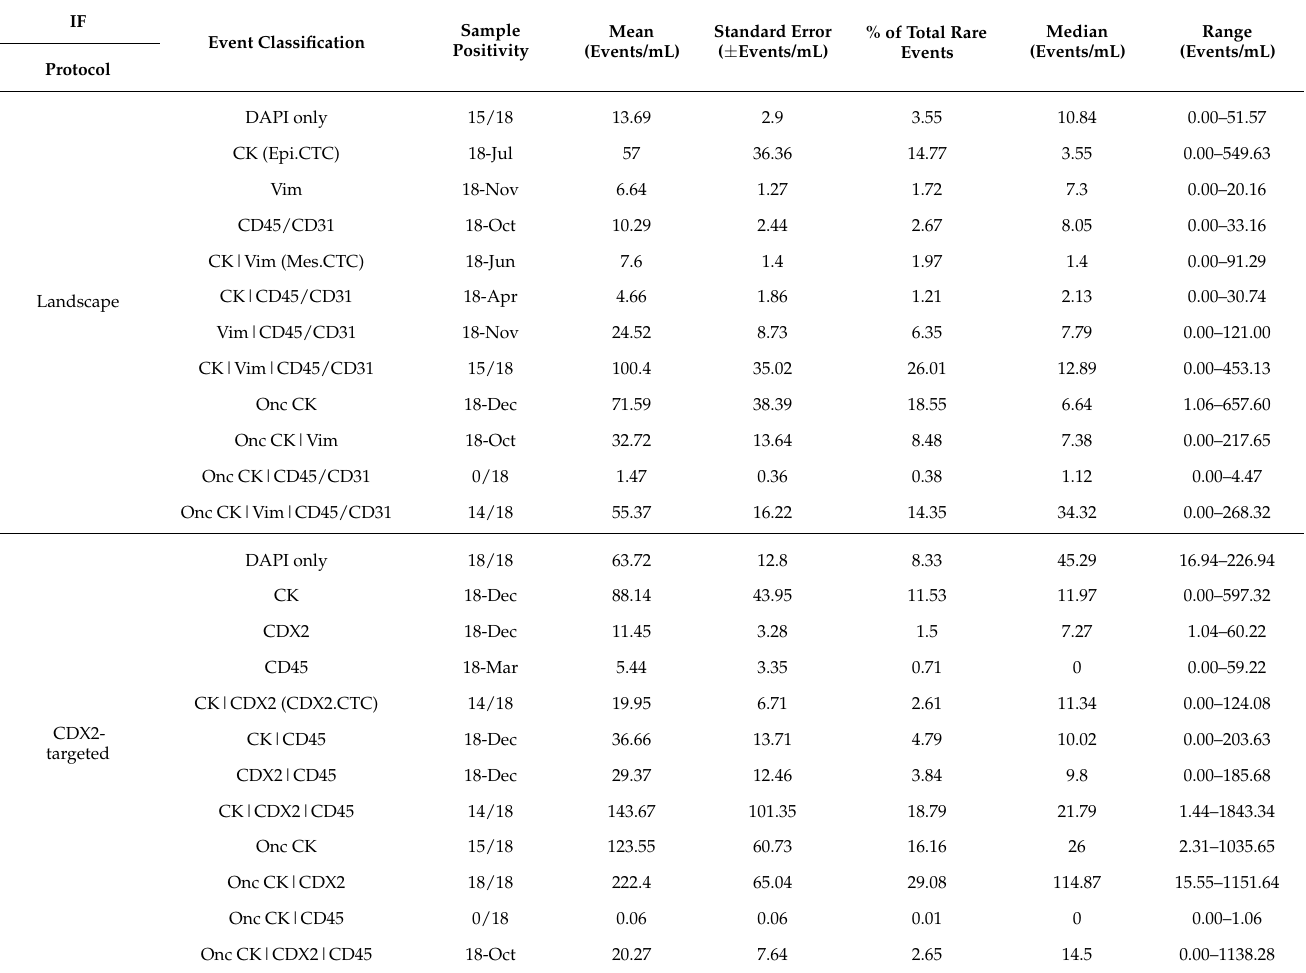
Table 1. Rare-event frequencies, enumerations and sample positivity from the Landscape and CDX2- targeted immunofluorescence (IF) protocols. The sample positivity threshold of ≥ 5 events/mL was determined by comparisons to the rare-event enumerations of a randomly selected normal donor cohort. The frequency of each classification is provided as a percentage of the total rare-event profile for each IF